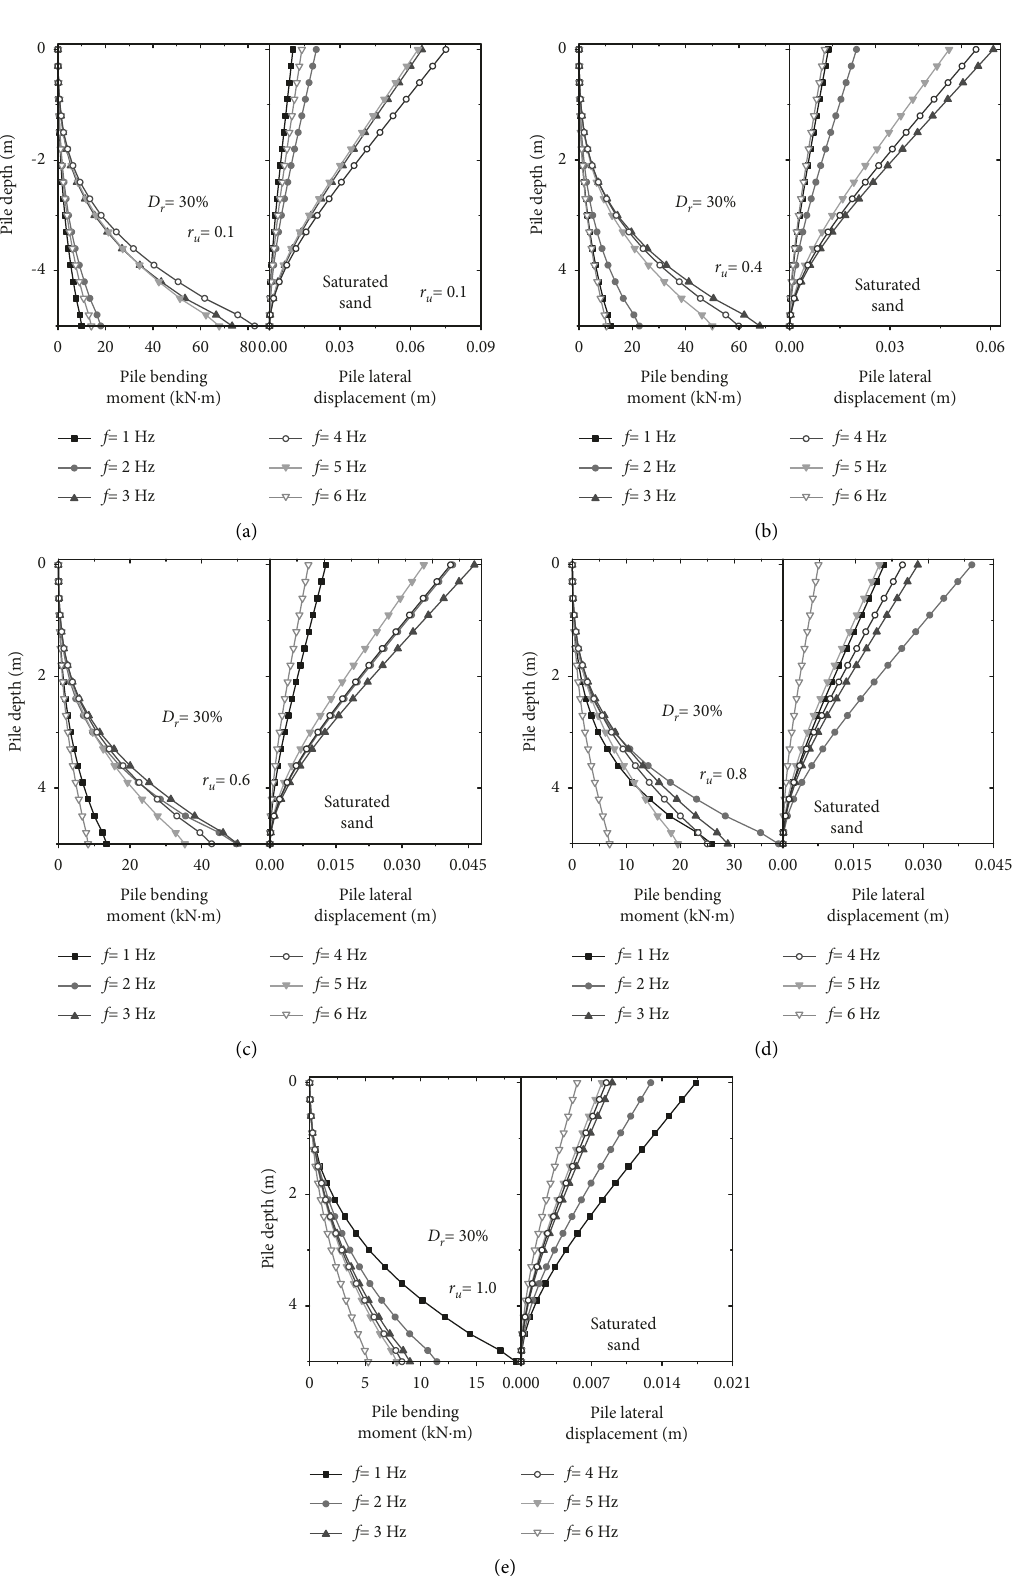
u (cid:31) 0.1; (b) r u (cid:31) 0.4; (c) r u (cid:31) 0.6; (d) r u (cid:31) 0.8;